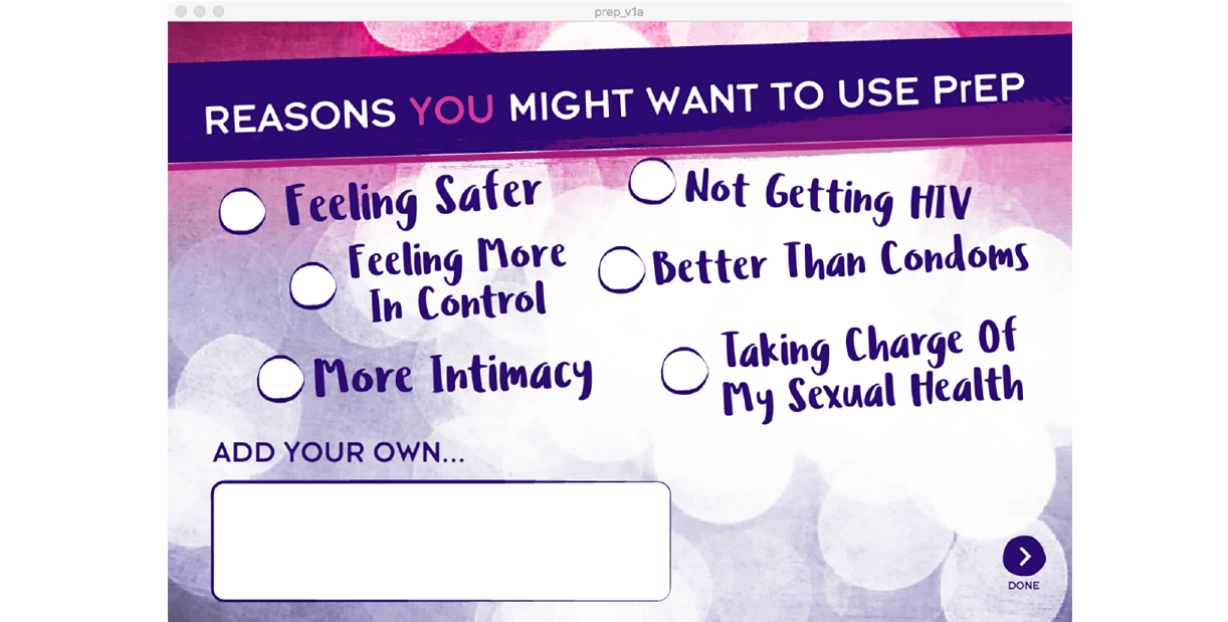
Figure 4. A screenshot of the Is pre-exposure prophylaxis Right for Me or My Partners? prototype